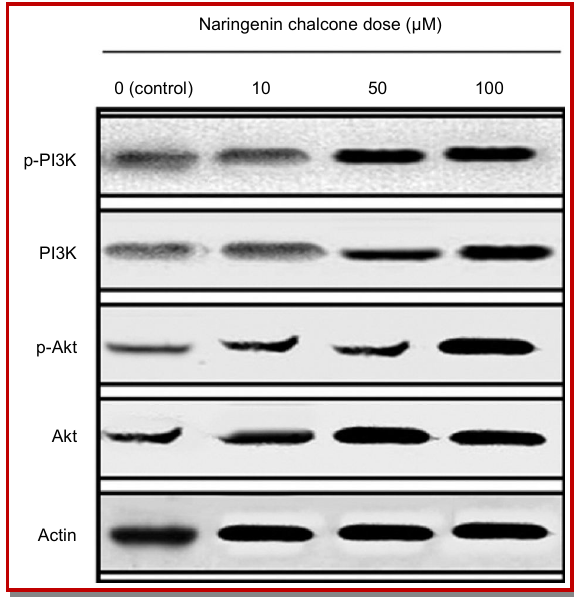
Figure 4: Naringenin chalcone targets PI3K/Akt signalling pathway in U87MG human glioblastoma cells. The cells were treated with 0, 10, 50 and 100 µM and the protein expressions were evaluated by Western blot. The treatment led to up- regulation of PI3K/Akt